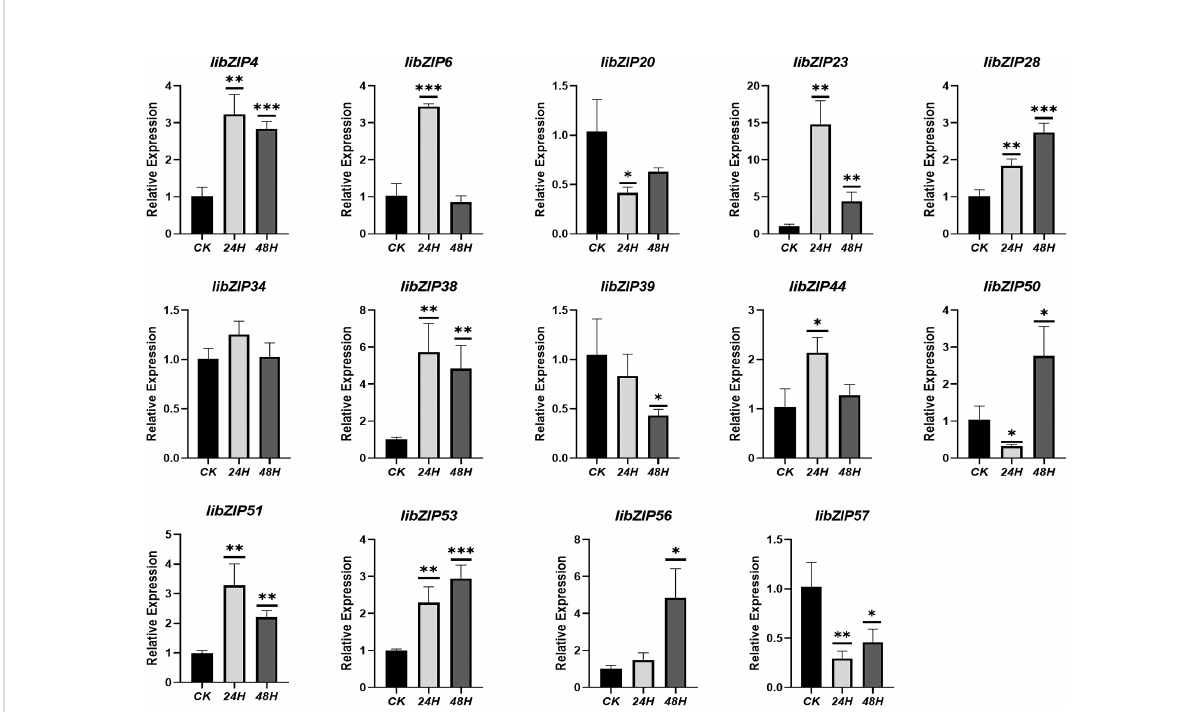
FIGURE 5 Relative expression levels of 14 differentially expressed IibZIP genes in I. indigotica leaves under salt stress for different durations detected by qRT-PCR. The X-axis indicates salt stress duration, the Y-axis indicates relative gene expression level. CK, non-stress environment. Error bars indicate the standard deviation of three repetitions. Asterisks denote a statistically signi fi cant difference (*p < 0.05, **p < 0.01, ***p < 0.001; Student ’ s